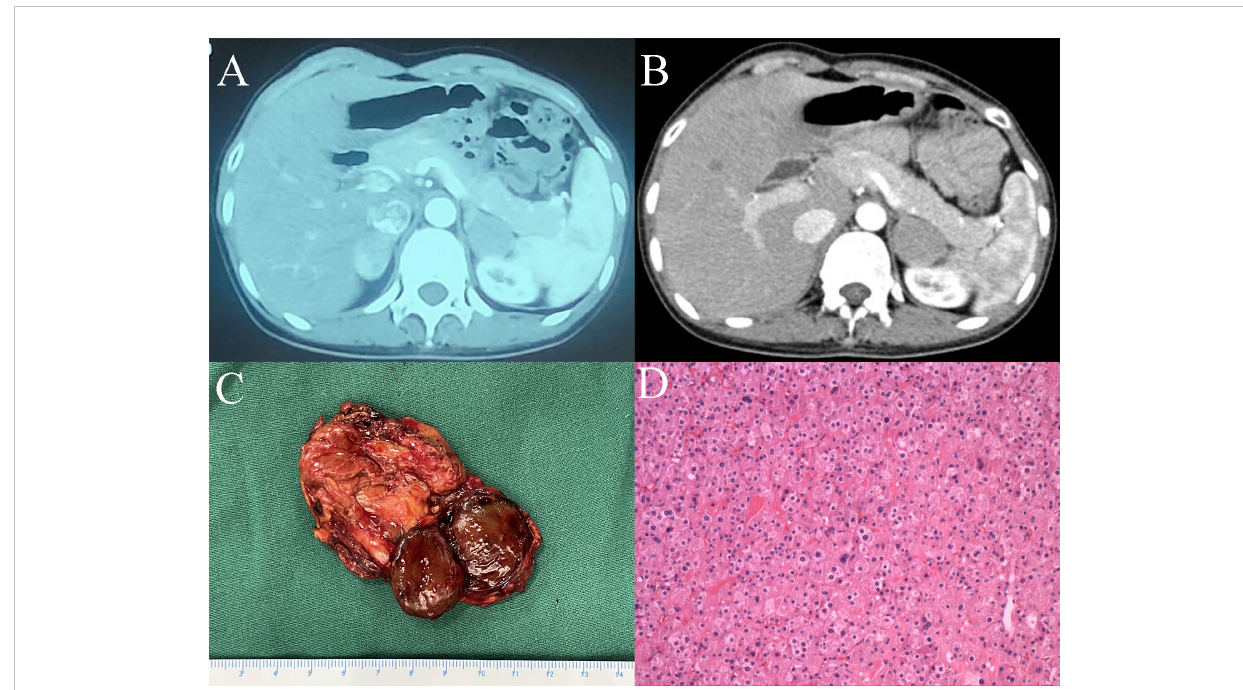
FIGURE 1 (A) CT image of bilateral adrenal tumors. (B) CT image of the left adrenal tumor after right adrenal tumorectomy. (C) Surgical specimen of the left adrenal tumor. (D) Haematoxylin and eosin staining of the left adrenal tumor (magni fi